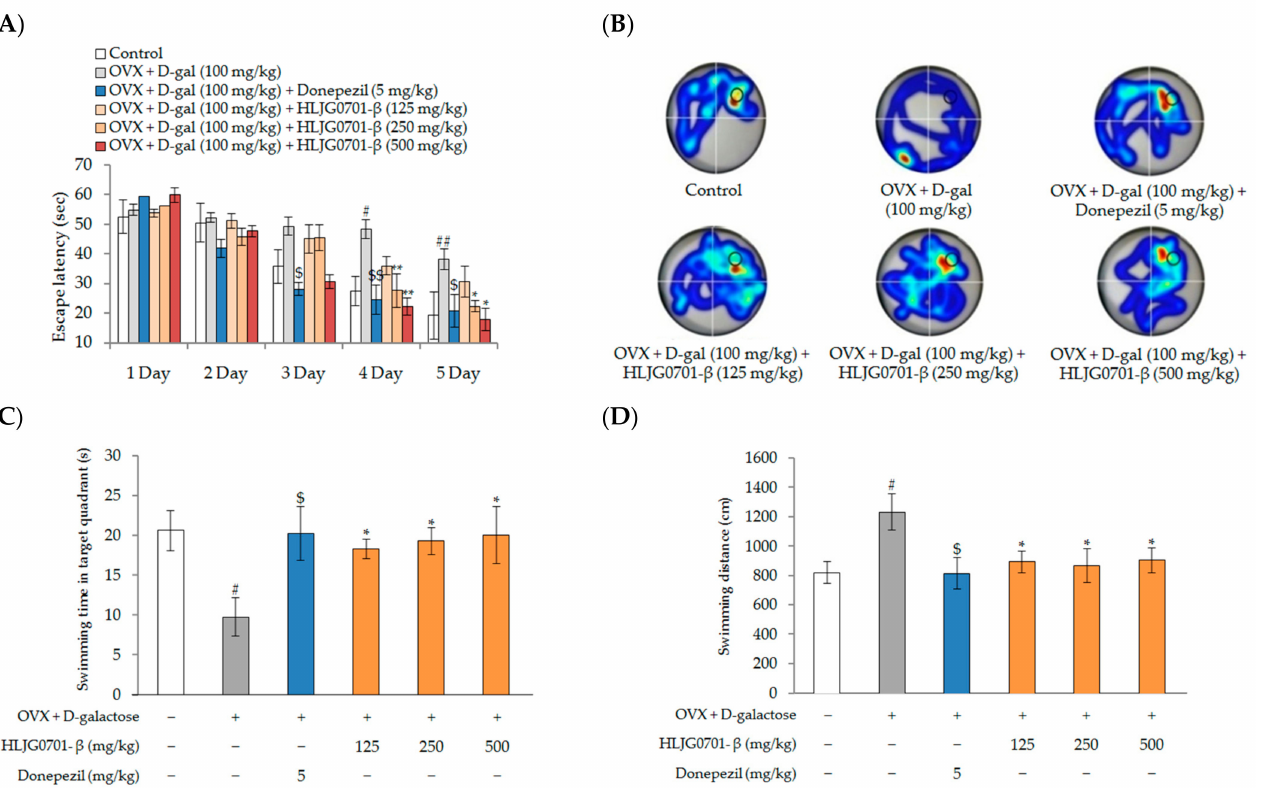
Figure 7. The Morris Water Maze task in OVX + D -galactose-induced female mice. ( A ) Escape latency; ( B ) heatmap images; ( C ) swimming time in target quadrant; ( D ) swimming distance. Data are presented as mean ± standard deviation. Error bar: standard deviation. ##, significant difference compared with control by Student’s t -test, p < 0.01; #, significant difference compared with control by Student’s t -test, p < 0.05; $$, significant difference compared with OVX + D -galactose group by Student’s t -test, p < 0.01; $, significant difference compared with OVX + D -galactose group by Student’s t -test, p < 0.05; **, significant difference compared with OVX + D -galactose group by one-way ANOVA, p < 0.01; *, significant difference compared with OVX + D -galactose group by one-way ANOVA, p <